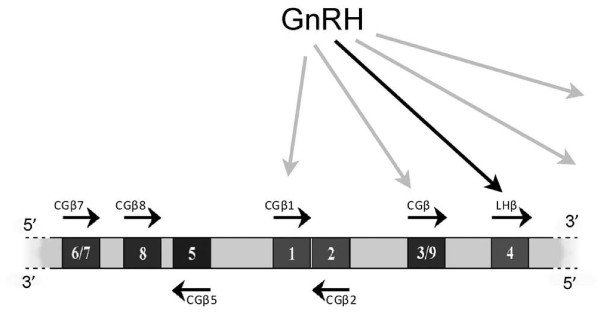
A diagrammatic representation of the arrangement of genes in the LHβ/hCGβ gene cluster on chromosome 19q13.32. The gray arrows show the postulated chance stimulation of hCG β-subunit genes by the GnRH promoting LH β-subunit gene transcription.